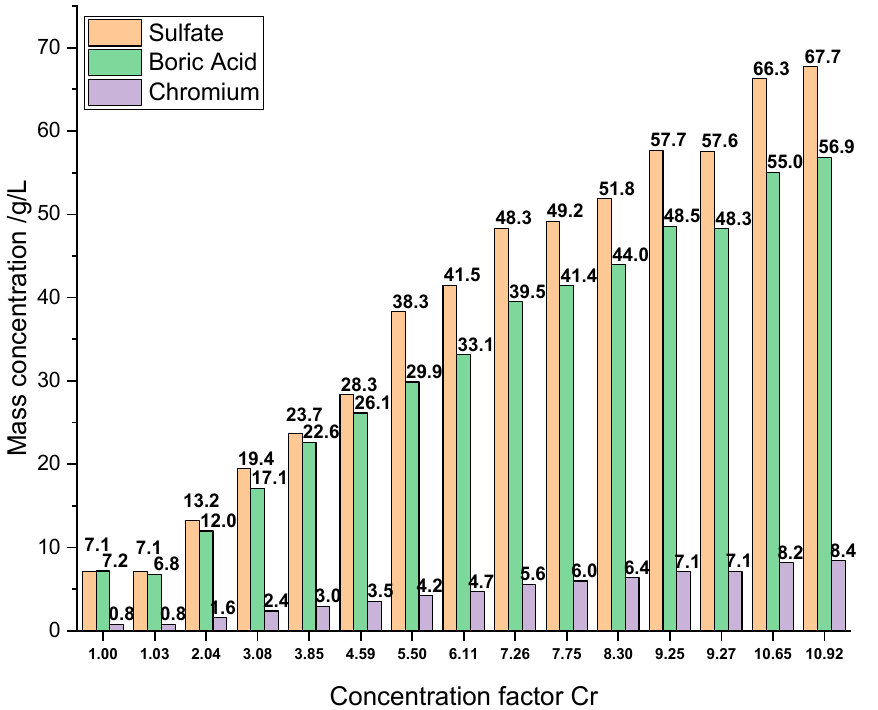
Figure 3. Mass concentration of sulfate, boric acid and chromium in the RO feed (cf 1.00) and concentrates K1.1-K14.1 (cf 1.03–10.92) as a function of the concentration factor (cf) of chromium in each stage of the series of consecutive experiments.